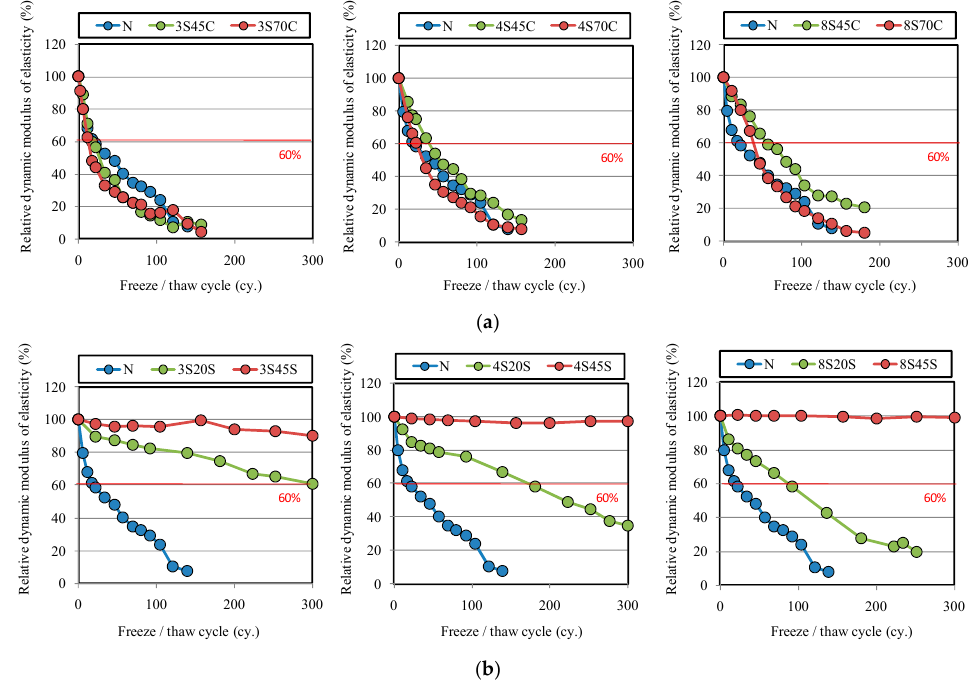
Figure 4. Relative dynamic modulus of elasticity for different mortar mixtures with or without BFS during freeze–thaw cycles: ( a ) replacement by BFS for cement and ( b ) replacement by BFS for sand.